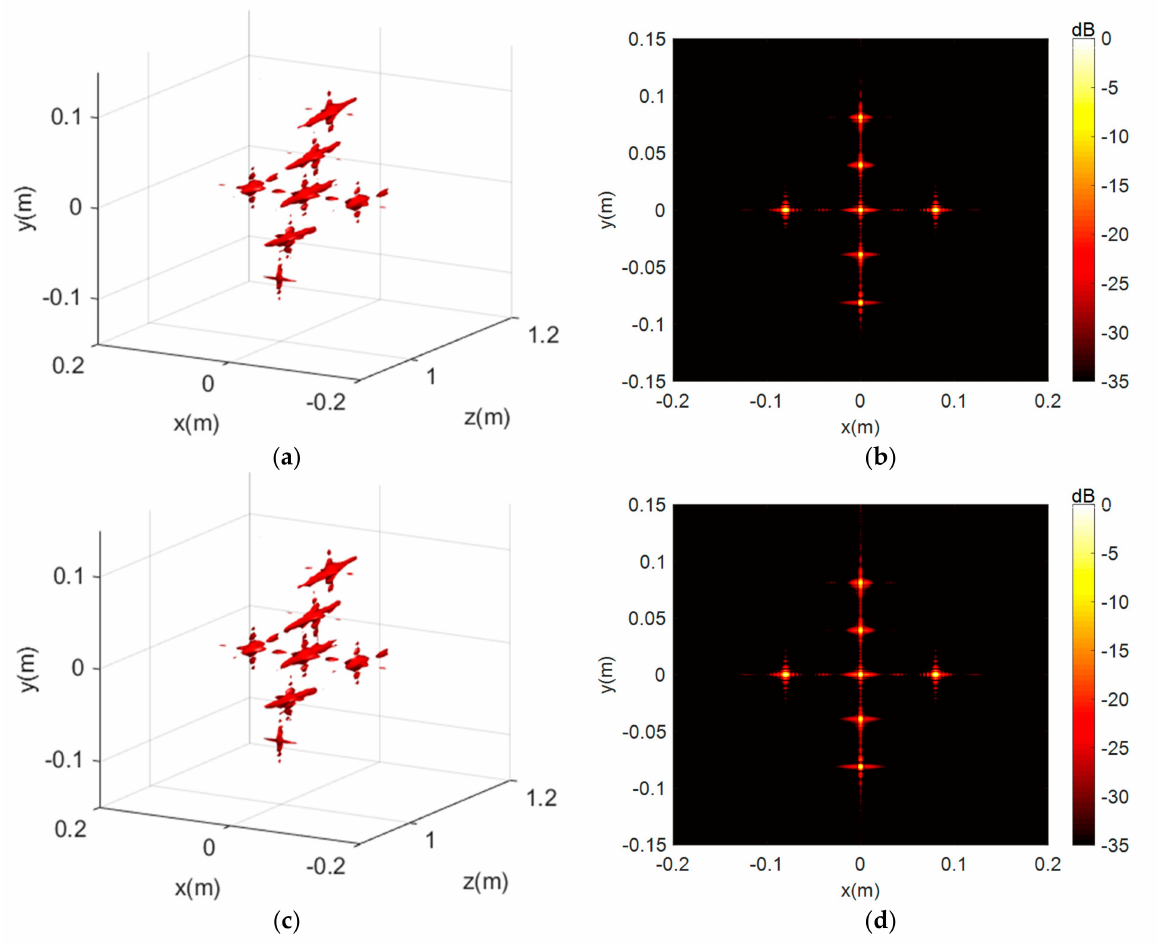
Figure 7. The simulation results without coherent factor processing. ( a , b ) are the 3D and 2D projection results of BPA. ( c , d ) are the 3D and 2D results of